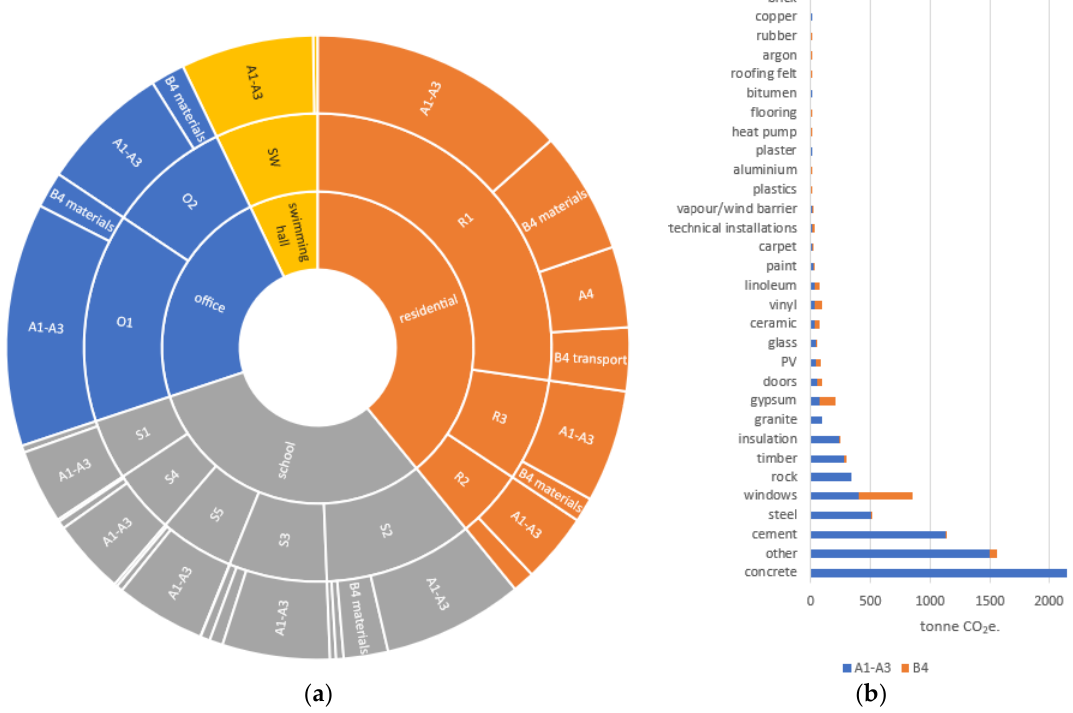
Figure 7. Example of how the distribution of emissions in a planned neighborhood could look like: ( a ) How the emissions for all buildings are distributed across typologies (inner circle), buildings (middle circle), and the life cycle phases included in each building study (outer circle); ( b ) The material groups that contribute the most to the overall emissions in A1–A3 and B4 (for all buildings with inventory) and thus where the largest potential for reduction in these life cycles lies. The buildings used here are not connected to an actual neighborhood; they are merely used as examples.